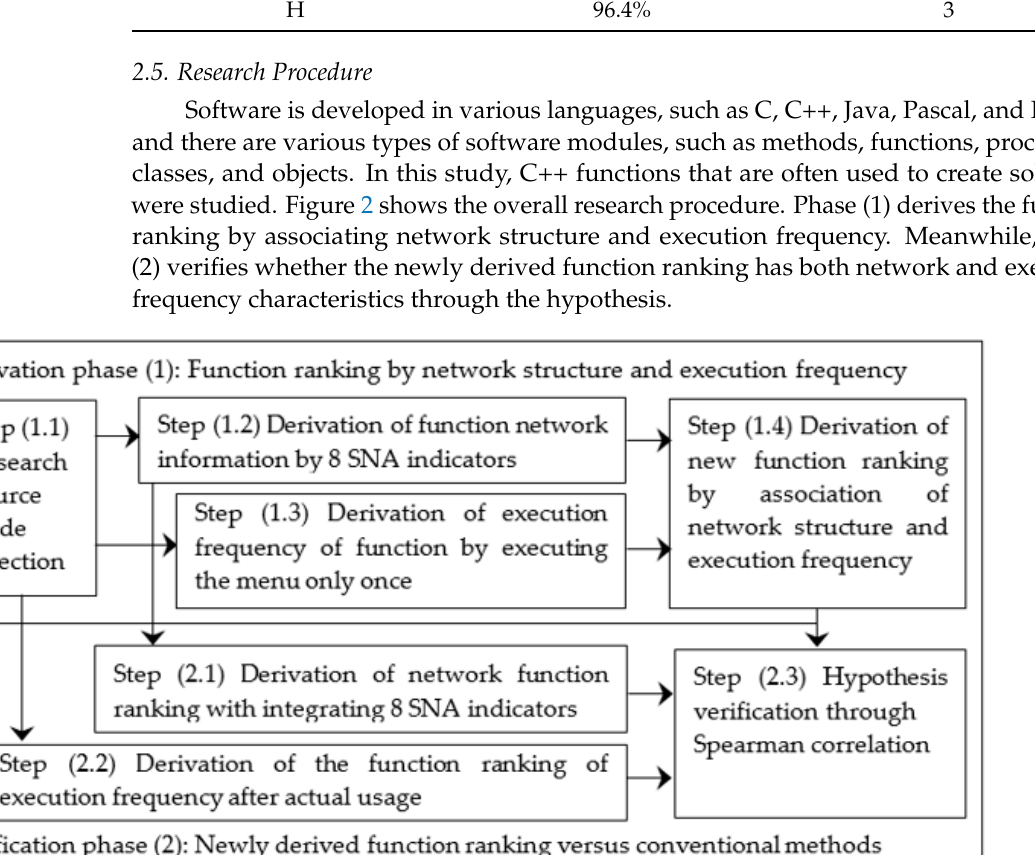
Figure 2. Overall research